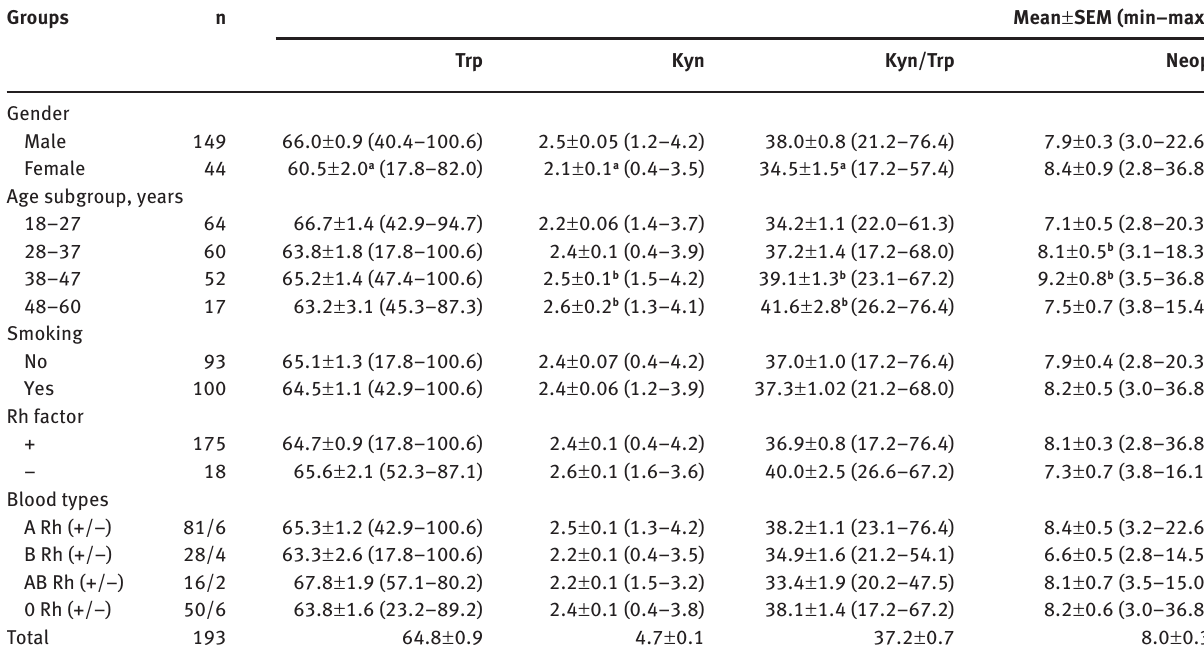
Table 1 Characteristics of donors and measured parameters.